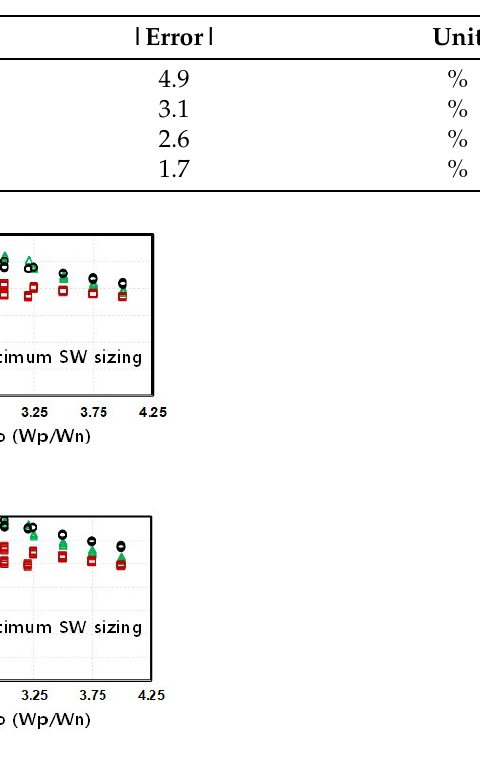
Table 3. ANN regression accuracy of the T/H module (ENOB).